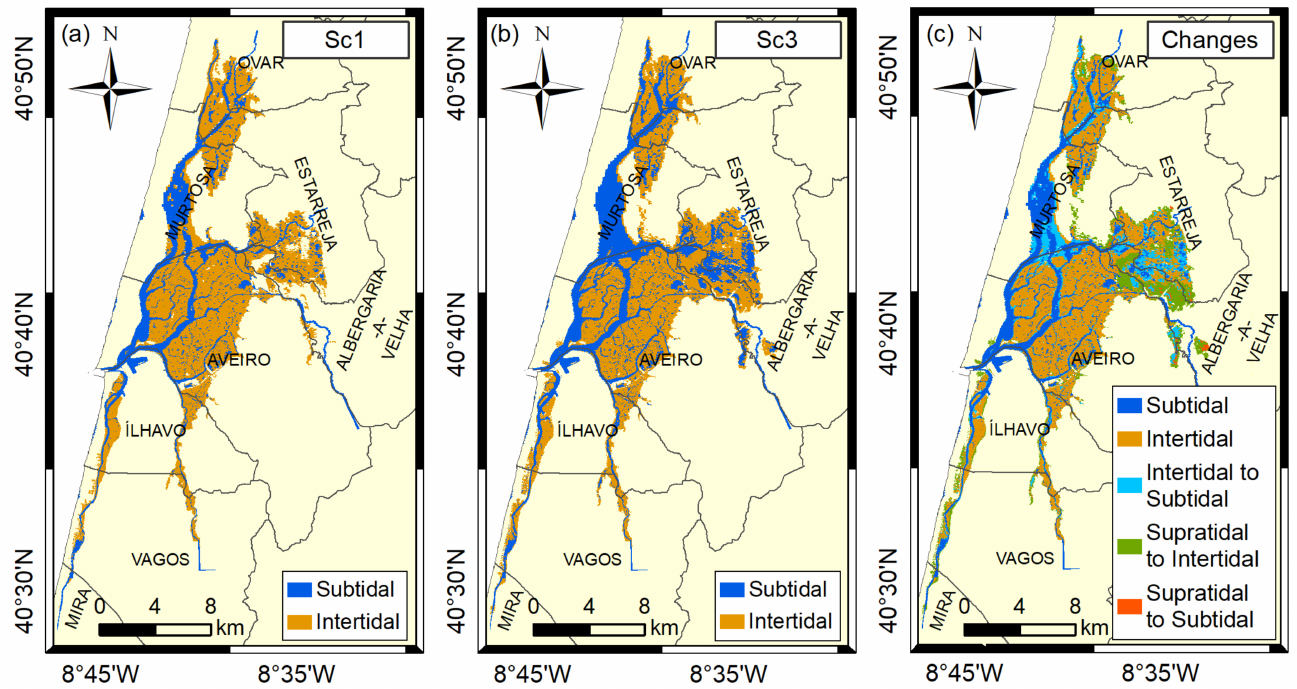
Figure 4. Subtidal and intertidal areas in the Ria de Aveiro under: present MSL ( a ) and future MSL ( b ). Changes in tidal classification ( c